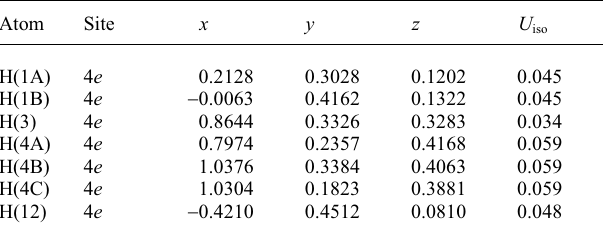
Table 2. Atomic coordinates and displacement parameters (in Å 2 )